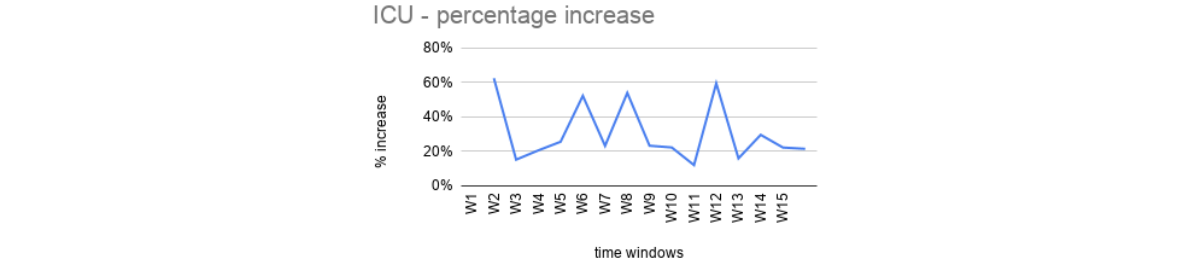
Figure 5. Percentage increase between the predicted and the observed ICU beds occupied. ICU: intensive care unit.